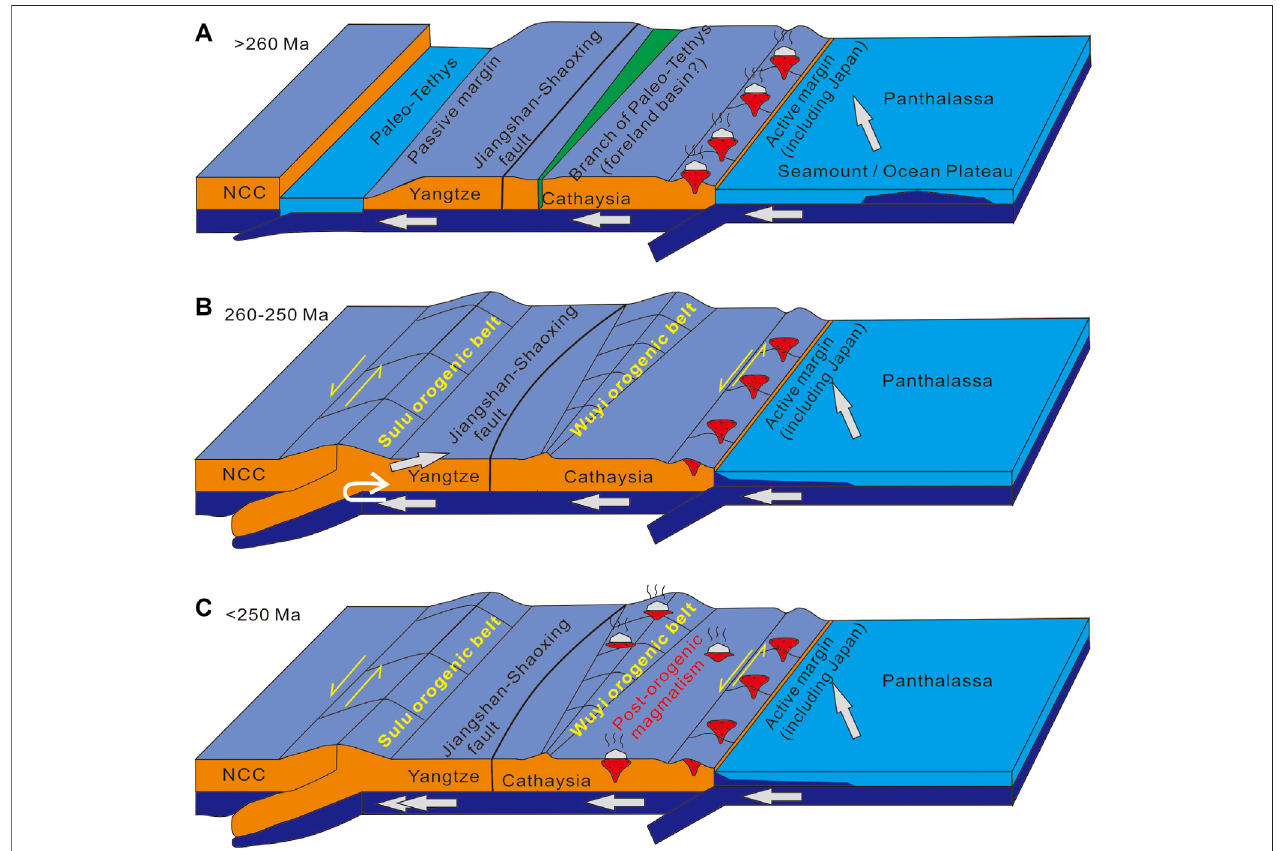
FIGURE 9 | Proposed tectonic evolutionary model for the formation of the Indosinian intraplate orogen in the SCB.